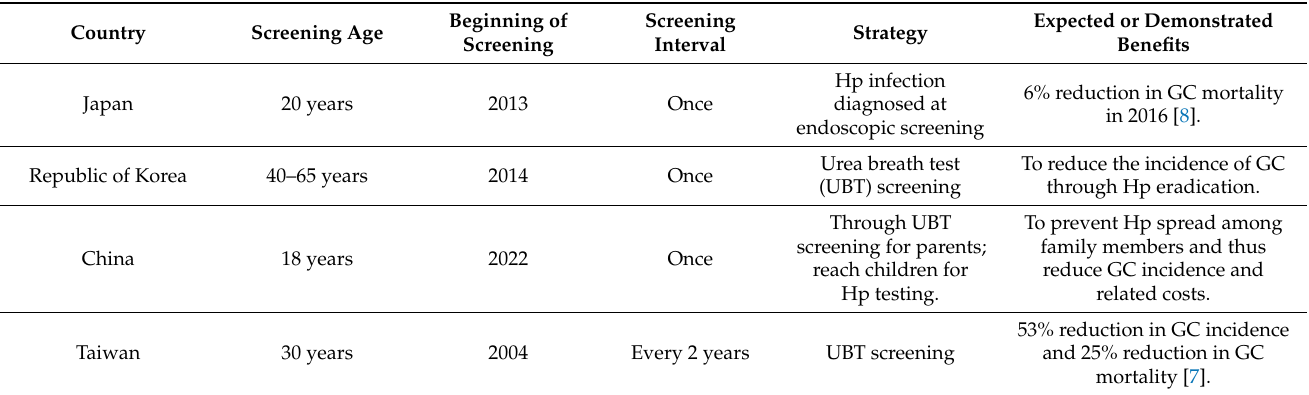
Table 1. Available screening programs for Hp